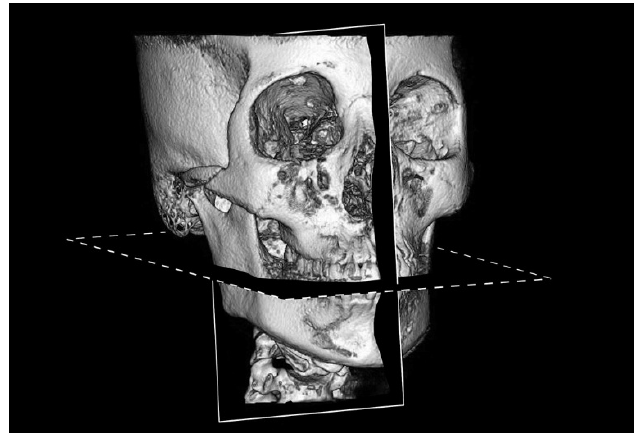
Figure 1. Reference planes used in this study. Midsagittal plane (solid line): the plane passing through the anterior nasal spine, crista galli, opisthion, and midpoint of the mandibular incisor tip. Mandibular occlusal plane (dotted line): the plane passing through the proximal buccal cusp of the mandibular first molar and the tip of the right mandibular central incisor.